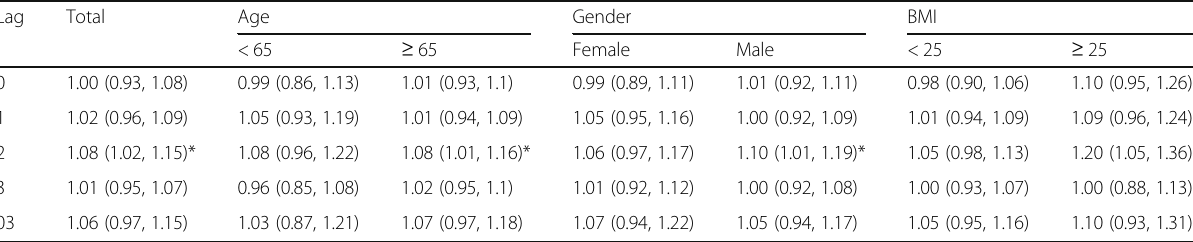
Table 3 Odds ratios of fatal ICH associated with an interquartile range increase in PM 2.5 levels (OR and 95% CI) Lag Total Age